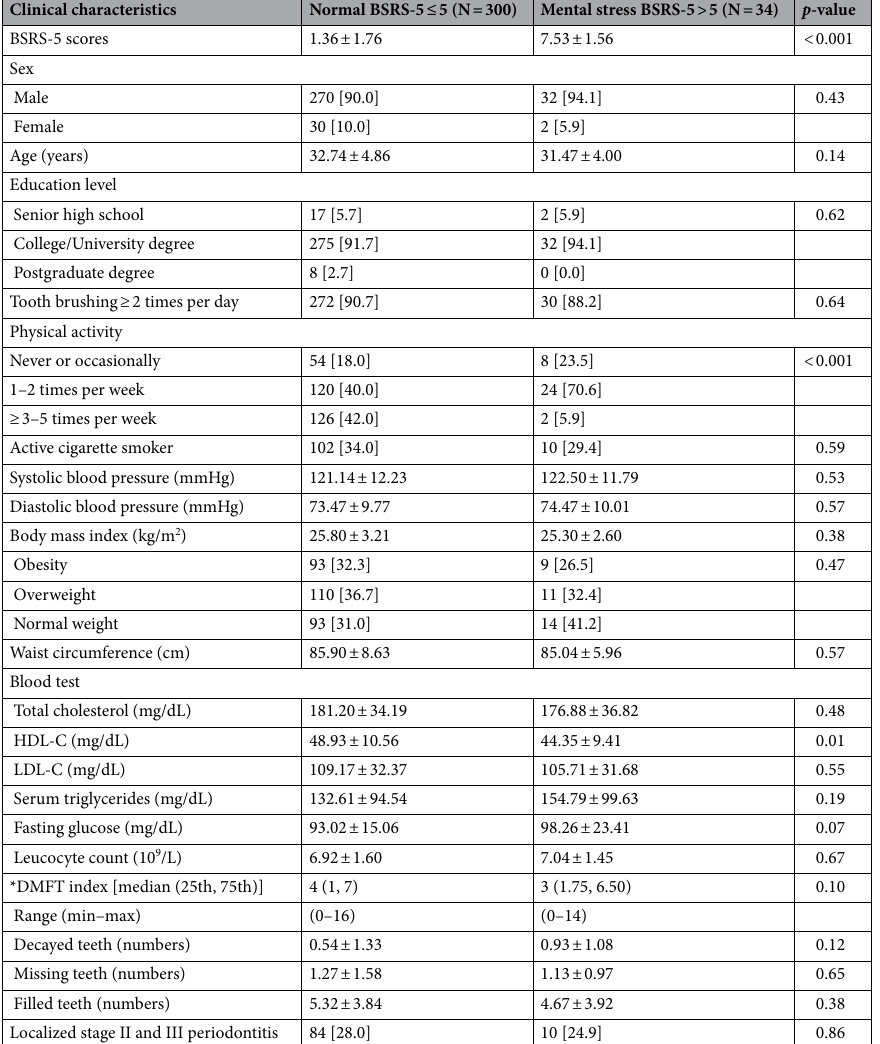
Table 1. Clinical characteristics of the normal and the symptomatic mental stress groups (N = 334). Continuous variables are expressed as mean ± SD (standard deviation), and categorical variables as N [%]. BSRS-5 brief symptom rating scale-5, DMFT decayed, missing and filled teeth numbers, HDL-C high-density lipoprotein cholesterol, LDL-C low-density lipoprotein cholesterol. *DMFT index was presented as median (25%, 75%) for the distribution skewed to